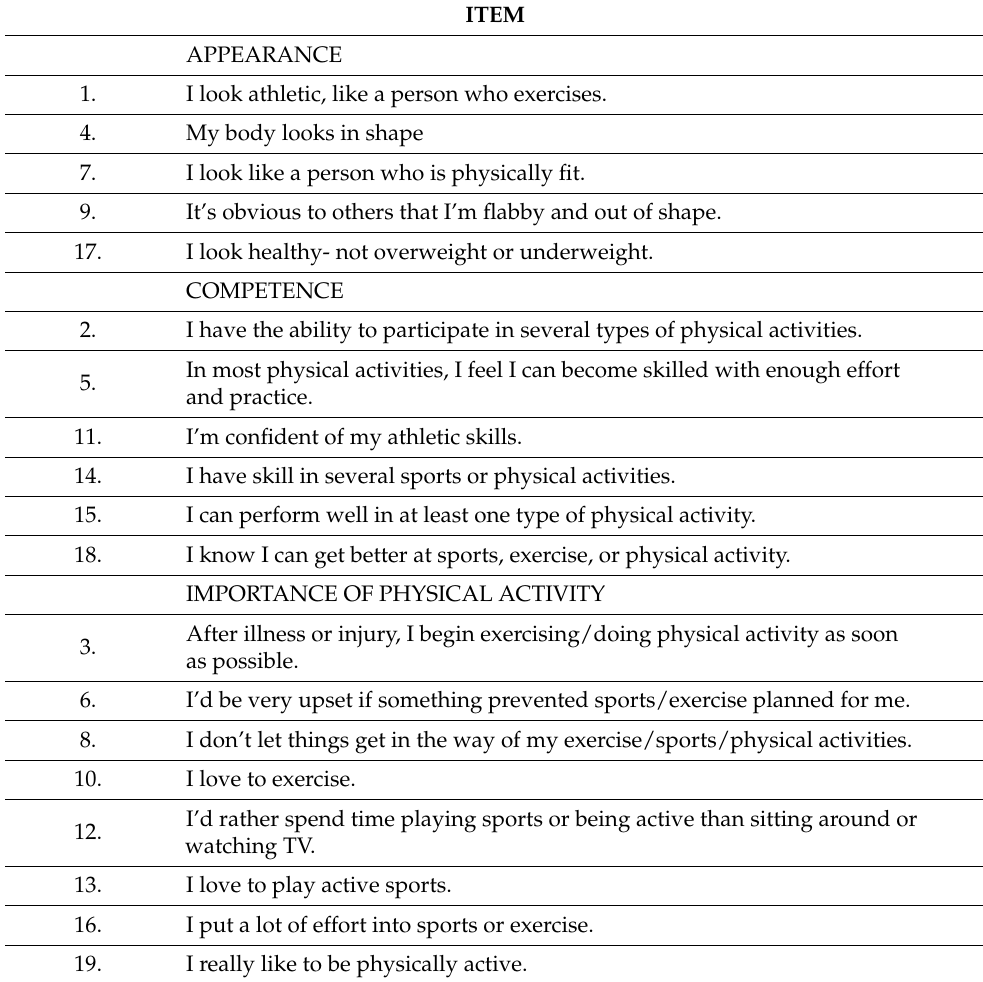
Table A3. Athlete Identity Questionnaire,